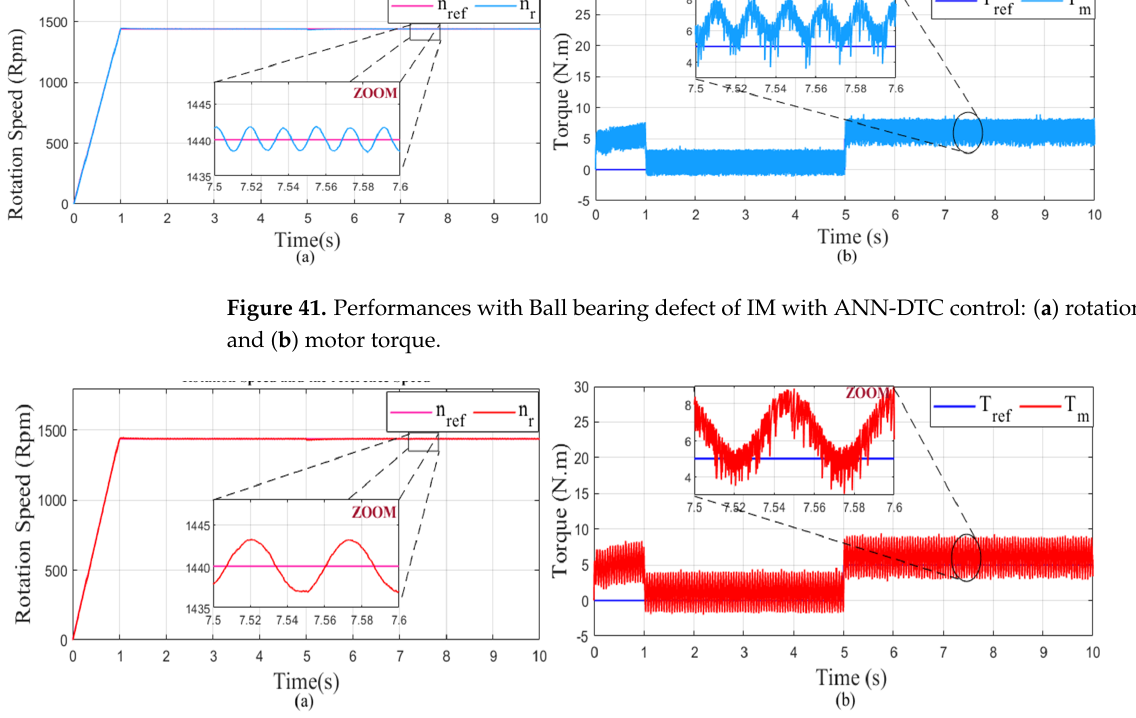
Figure 42. Performance with Cage bearing defect of IM with ANN ‐ DTC control: ( a ) rotation speed and ( b ) motor torque.